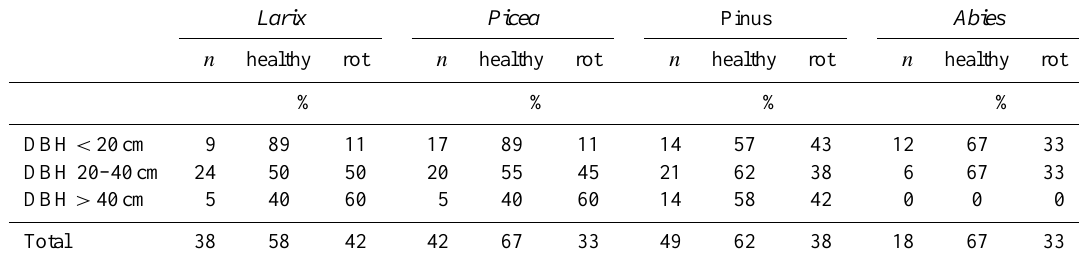
Table 6. The fraction of trees affected by fungal wood rot as related to tree species and tree dimension. Larix Picea Pinus Abies n healthy rot n healthy rot n healthy rot n healthy rot % % % % DBH < 20cm 9 89 DBH >